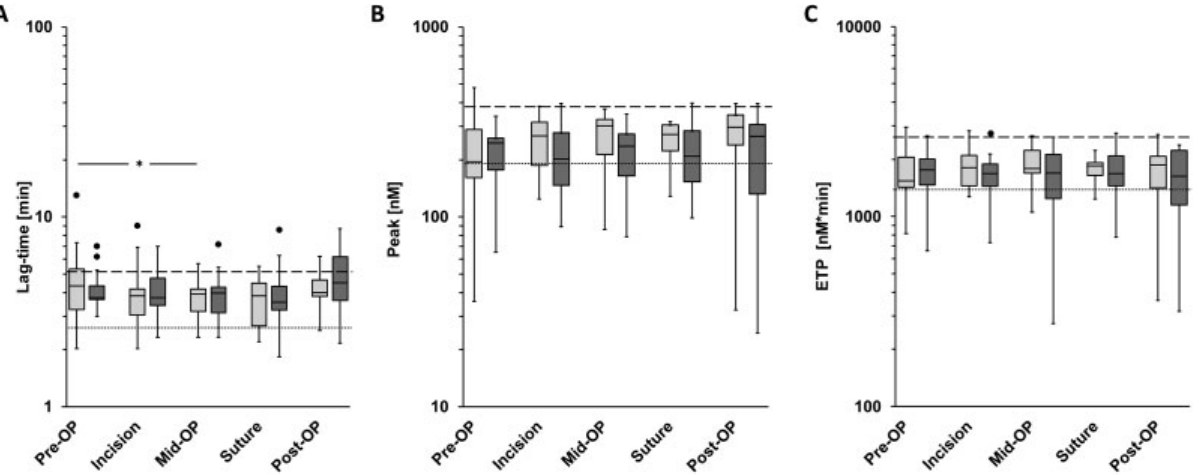
Fig. 1 In vitro thrombin generation kinetics in patients undergoing minor ( light gray boxes ) and major ( dark gray boxes ) orthopaedic surgeries. Changes in( A ) lagtime, ( B ) peak thrombingeneration, and( C ) endogenousthrombinpotential (ETP) were measuredat the indicatedtime points using CAT as outlined in the text. Data are expressed as box and whiskers plots with median, minimal and maximal values, interquartile ranges, and outliers. The dashed and dotted horizontal lines represent the established upper and lower reference limit. Signi fi cant differences ( p < 0.05) between blood collecting time points are indicated by a line dragged between the groups (- (cid:1)